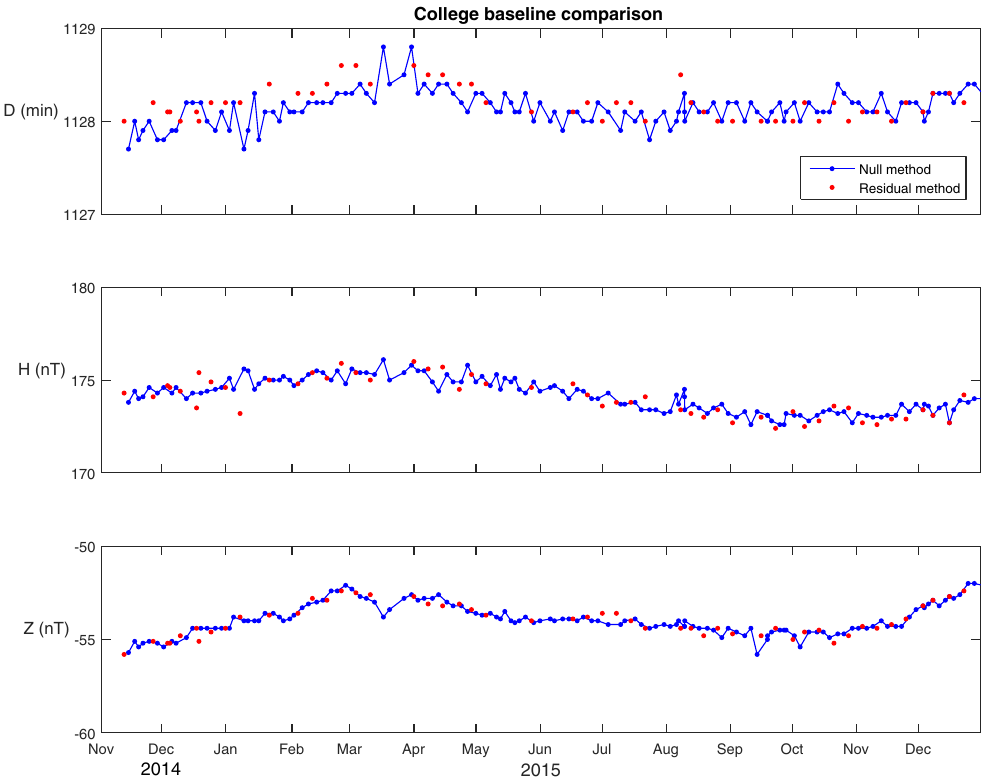
Figure 3. Comparison of baseline measurements using the null and residual methods at College Magnetic Observatory in 2014 and 2015. The three graphs show that there is considerable agreement between the null and residual methods. The D graph has a 2.0min scale and the differences are only about 0.1 or